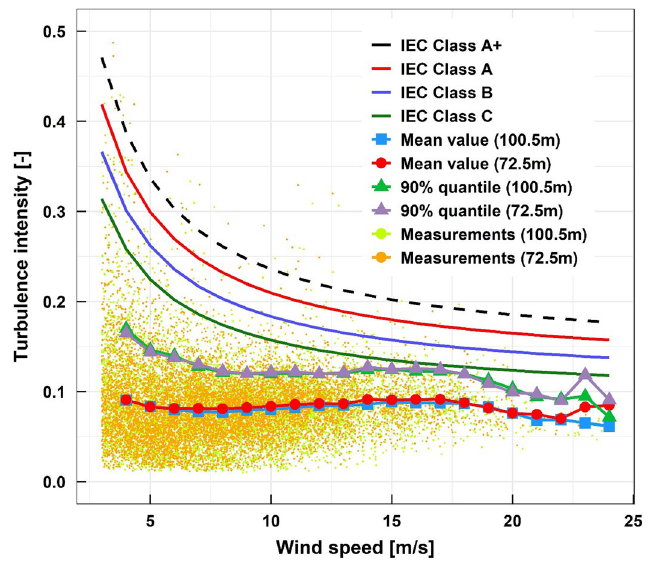
Figure 7. Turbulence intensity